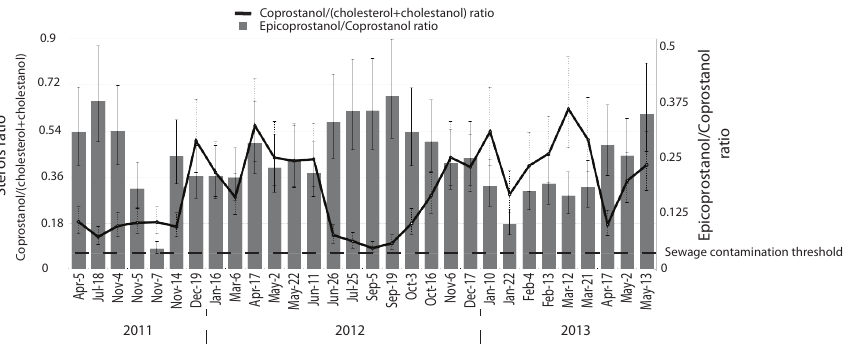
Figure 6. Coprostanol:(cholesterol + cholestanol) and epicoprostanol : coprostanol ratios of the different samples. Full error shown here incorporates the 14% analytical standard error estimated for lipid quantification for all terms of the ratios. Contamination threshold is 0.06 (See Sect. 3.3.2).